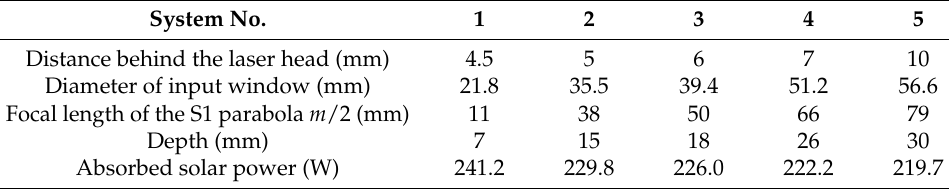
Table 2. Parameters of the parabolic surface S1 and absorbed solar power for each system investigated. System